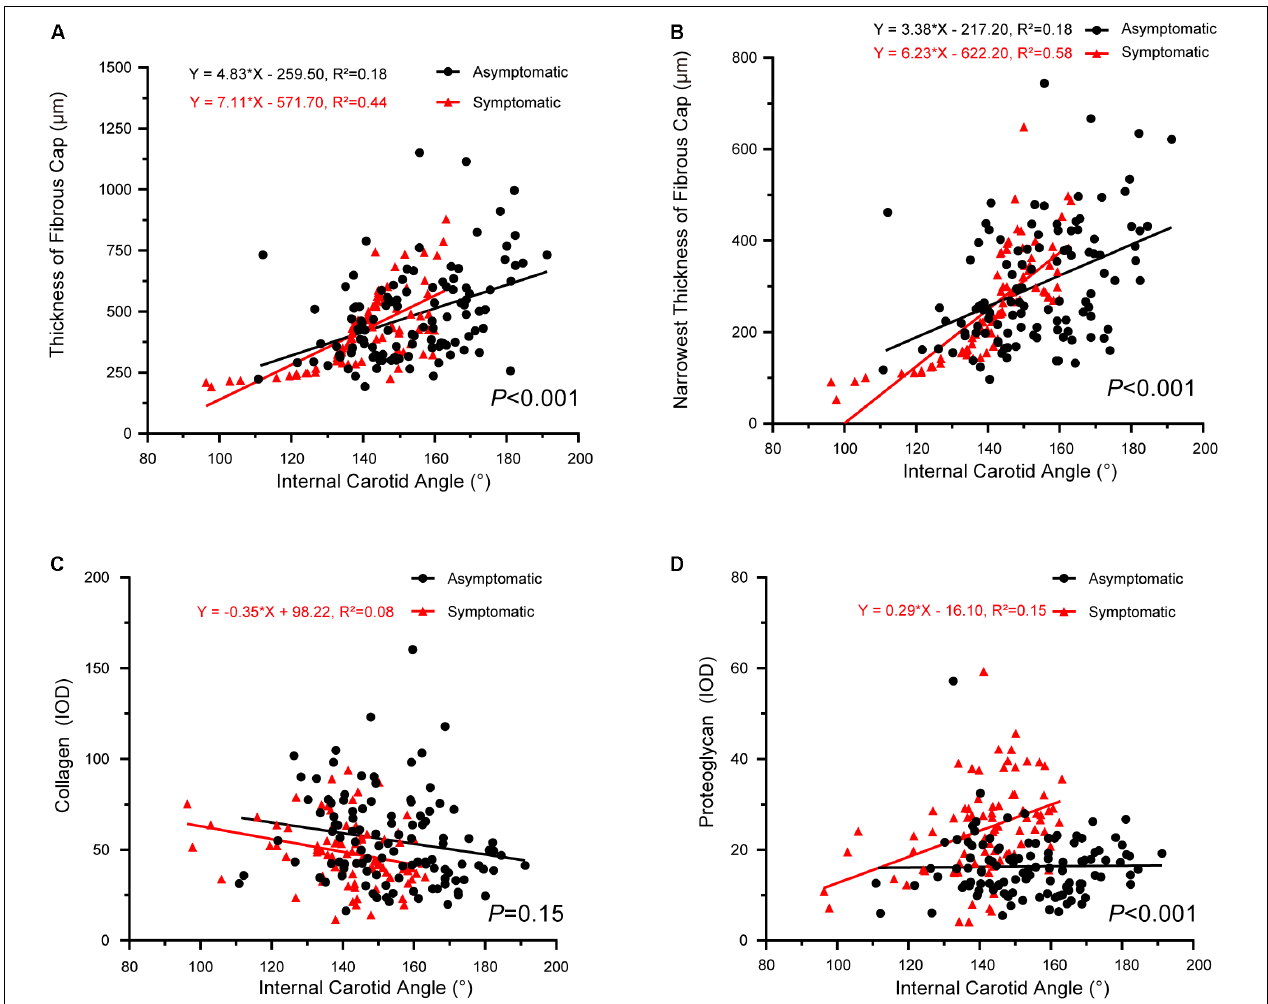
FIGURE 5 | Correlation between internal carotid angle and plaque pathology. (A) Linear regression model of fibrous cap thickness and internal carotid angle (asymptomatic: P < 0.001, R 2 = 0.18; symptomatic: P < 0.001, R 2 = 0.44); interaction between two groups had statistical significance ( P < 0.001). (B) Linear regression model of narrowest thickness of fibrous cap and internal carotid angle (asymptomatic: P < 0.001, R 2 = 0.18; symptomatic: P < 0.001, R 2 = 0.58); interaction between two groups had statistical significance ( P < 0.001). (C) Linear regression model of thickness of collagen and internal carotid angle (asymptomatic: P > 0.05; symptomatic: P < 0.001, R 2 = 0.08); interaction between two groups had no statistical significance ( P = 0.15). (D) Linear regression model of proteoglycan and internal carotid angle (asymptomatic: P > 0.05; symptomatic: P < 0.01, R 2 = 0.15); interaction between two groups had statistical significance ( P <